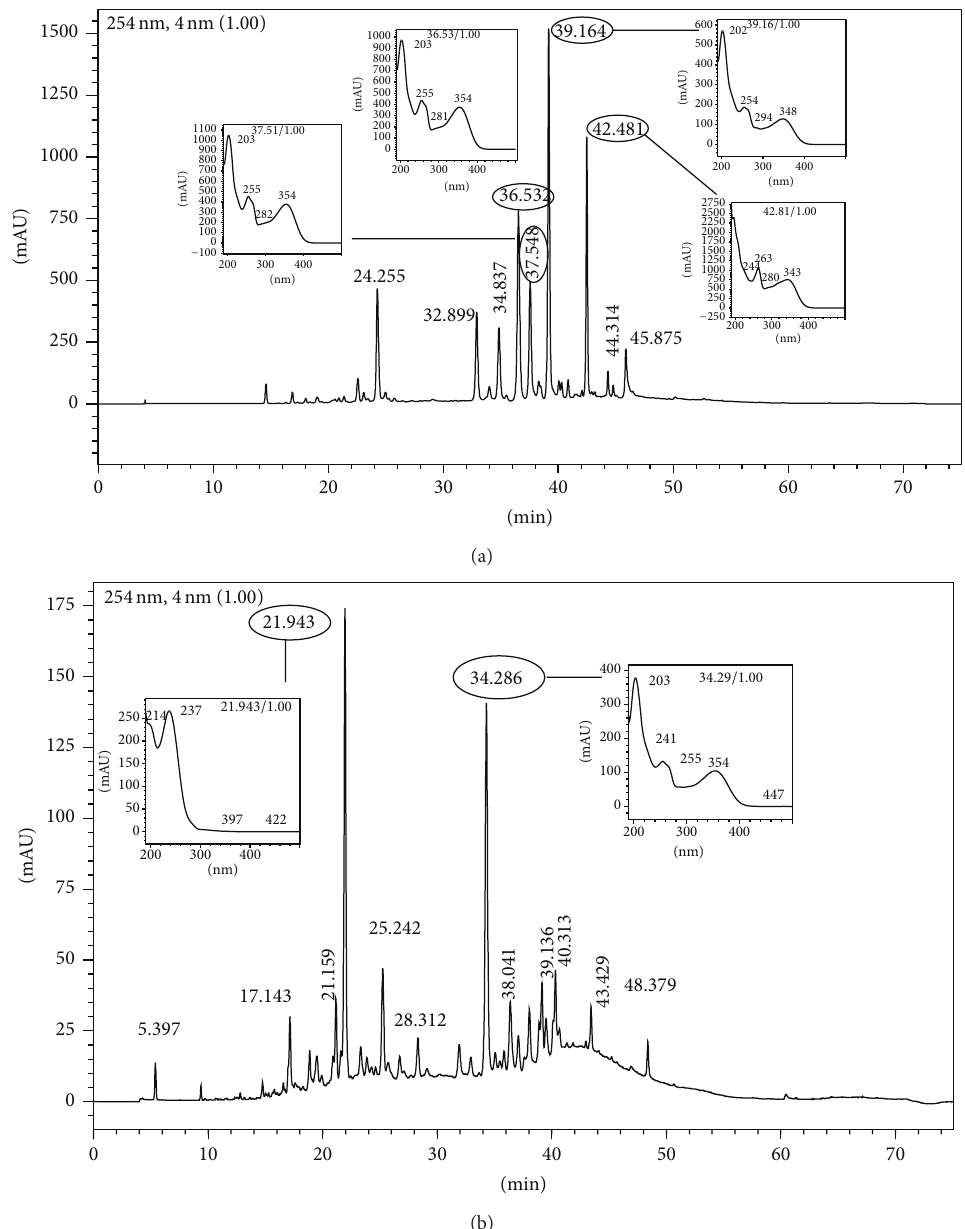
Figure 3: (a) Chromatogram at 254 nm of ethyl acetate fraction from leaves of Ocotea notata by HPLC. Emphases for the UV spectrum of peaks 36.53; 37.55; 39.16; and 42.48 min. (b) Chromatogram at 254 nm of butanol fraction from leaves of Ocotea notata by HPLC. Emphases for the UV spectrum of peaks 21.943 and 34.286